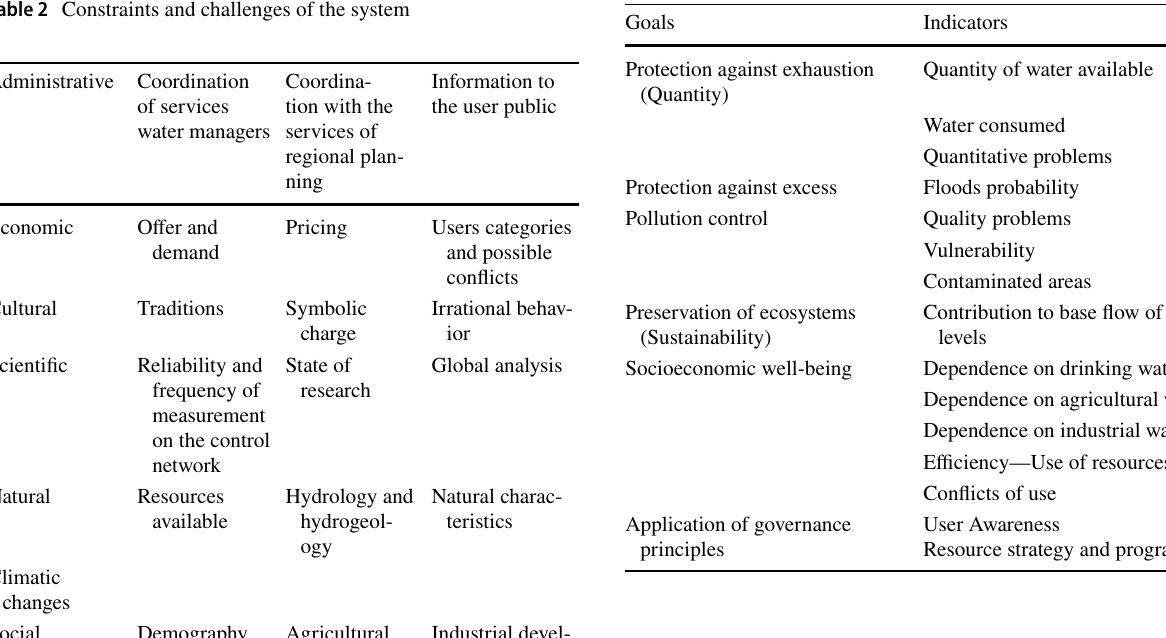
Table 3 Goals of water resources